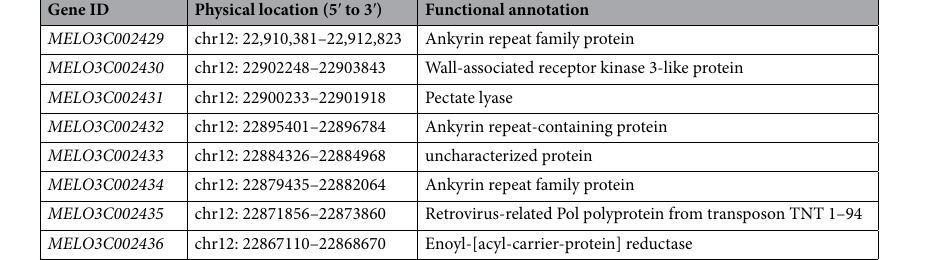
Table 2. Genes located in the mapping